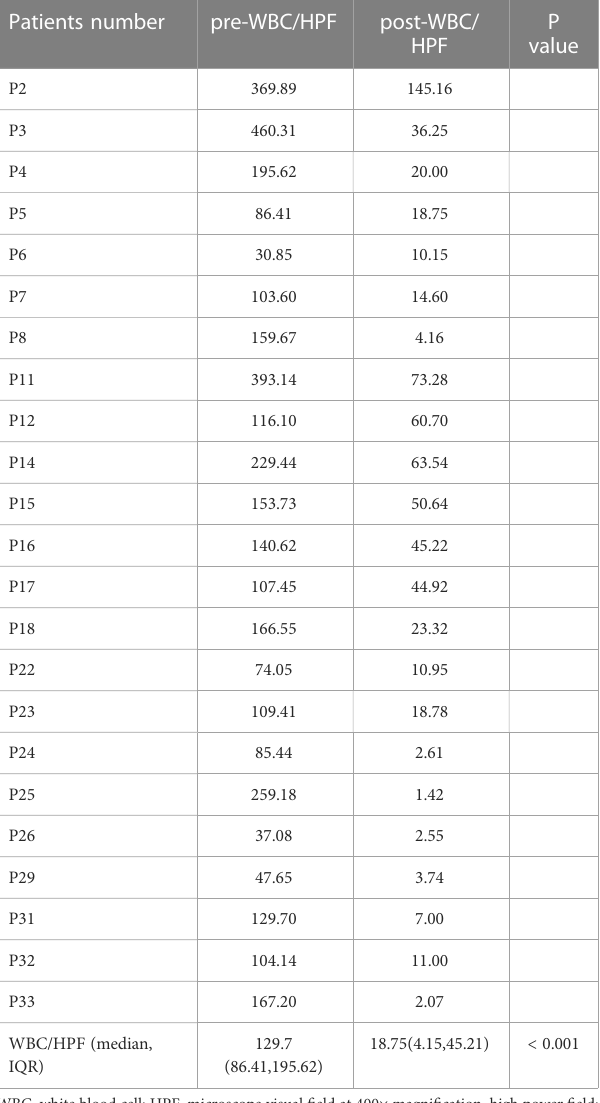
TABLE 7 Change in white blood cells in high power fi eld (WBC/HPF) counts of urinalysis before (pre-WBCHPF) and after (post-WBCHPF) targeted anti-infective